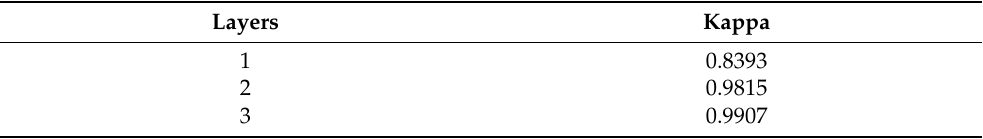
Table 4. Kappa coefficient under different layers.